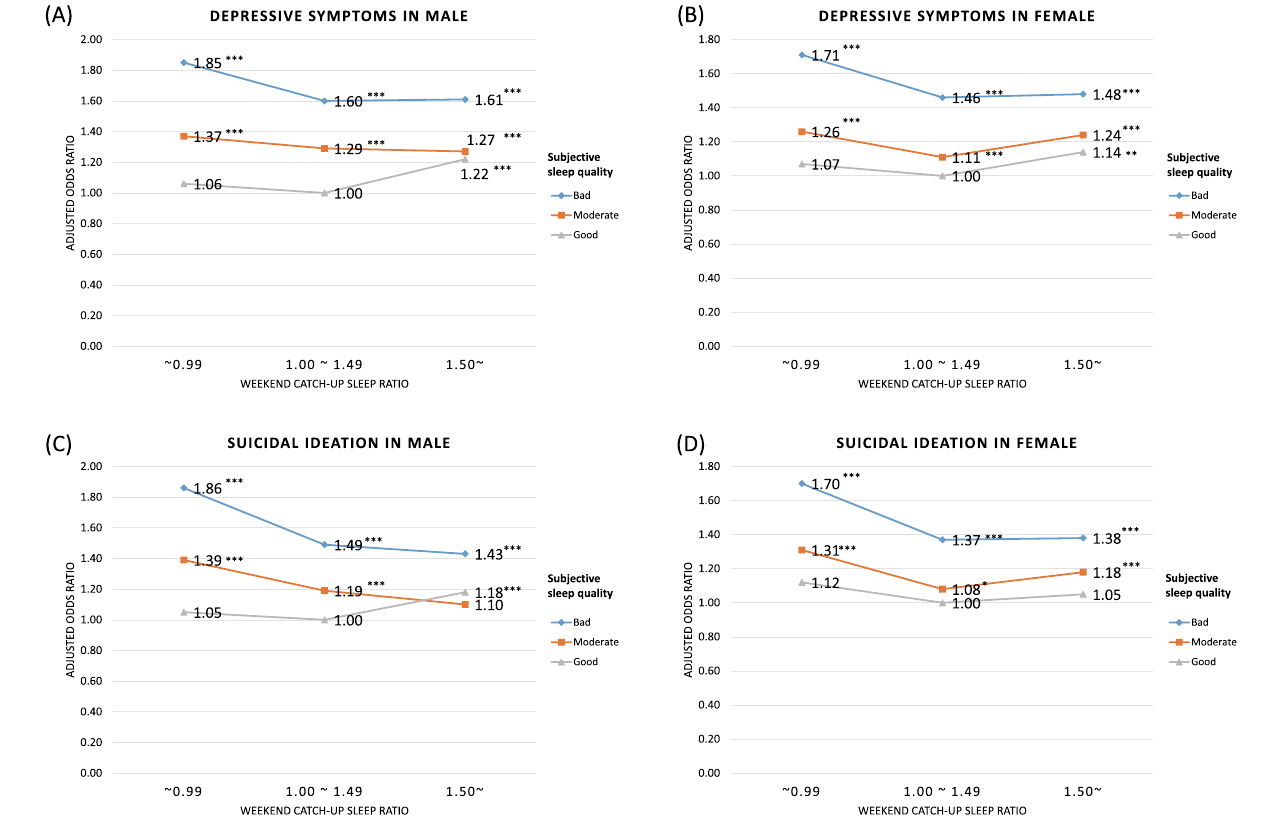
Figure 2. Results of the multiple logistic regression analysis, including interaction between weekend CUS ratio and subjective sleep quality. * P value < 0.05; ** < 0.01; *** < 0.001. CUS catch-up sleep.